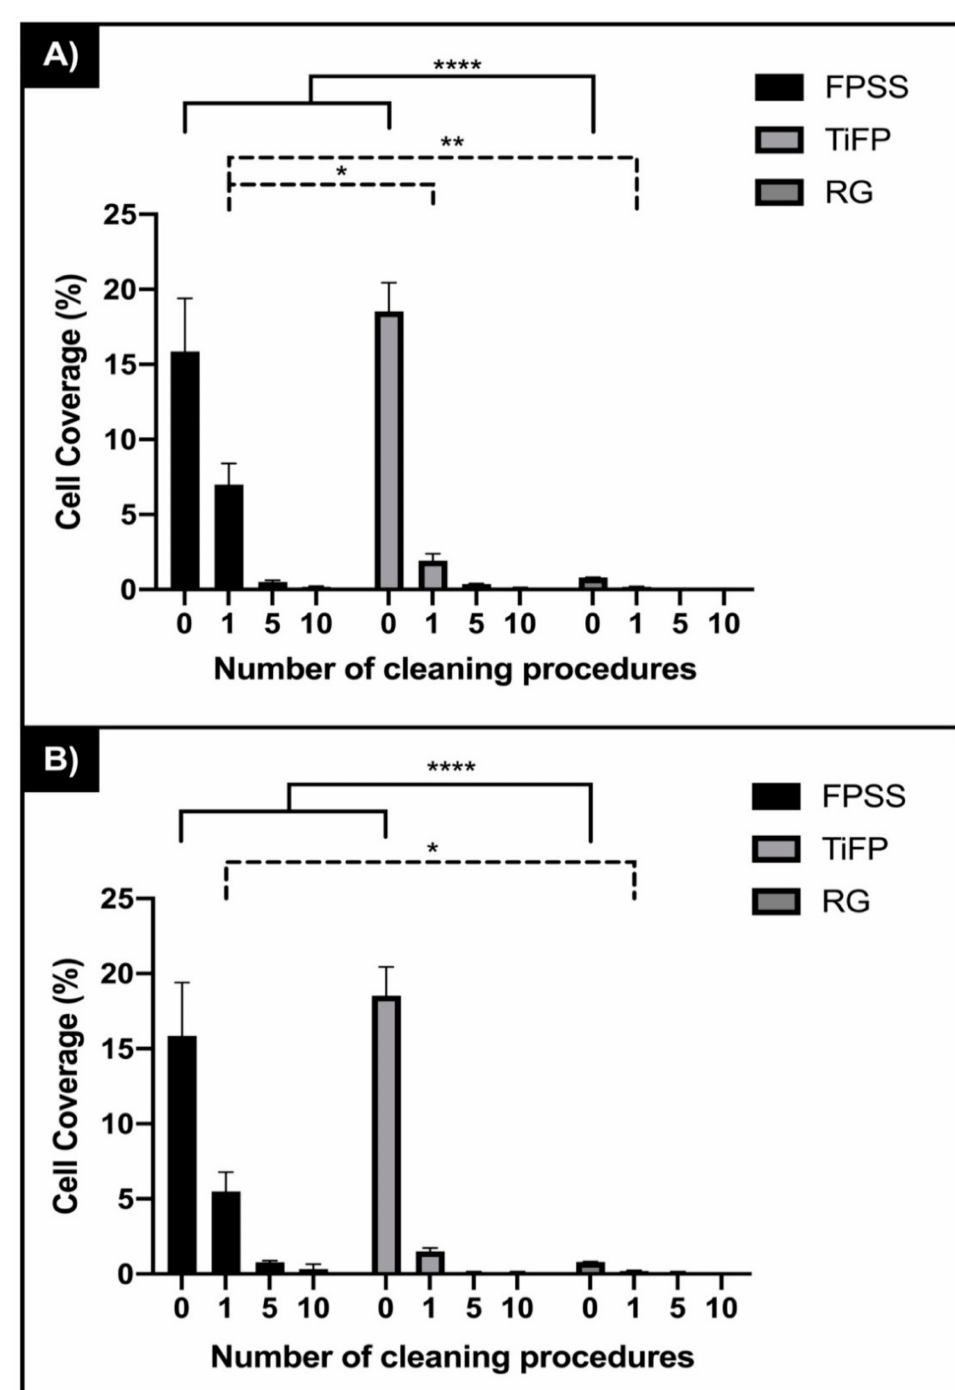
Figure 2. Percentage coverage bacteria retained on fine polished stainless steel (FPSS), titanium polished stainless steel (TiFP) and the regular linear featured titanium coated surface (RG) surface following 0, 1, 5 and 10 cleans ( A ) along the direction and ( B ) perpendicular to the surface features ( n = 45). Asterisks denote significance, * p ≤ 0.05, ** p ≤ 0.01 and **** p ≤